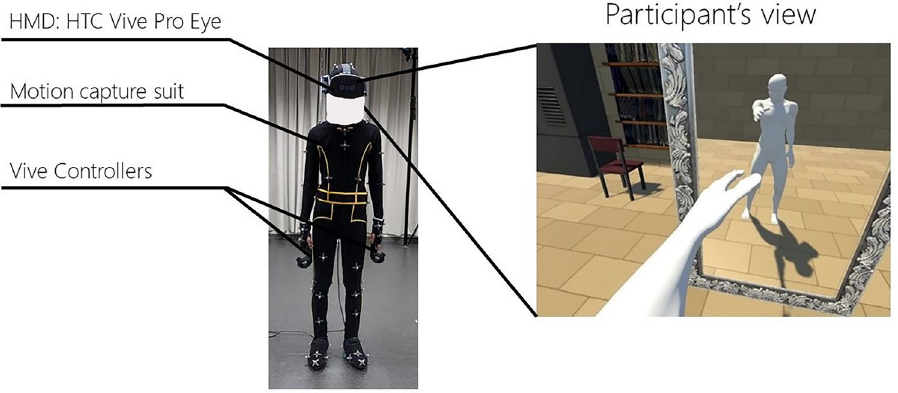
Figure 4. A participant wearing the devices (left) and the participant’s view (right). The figure on the right was made with Unity 2017.4.5f1 (unity.com).